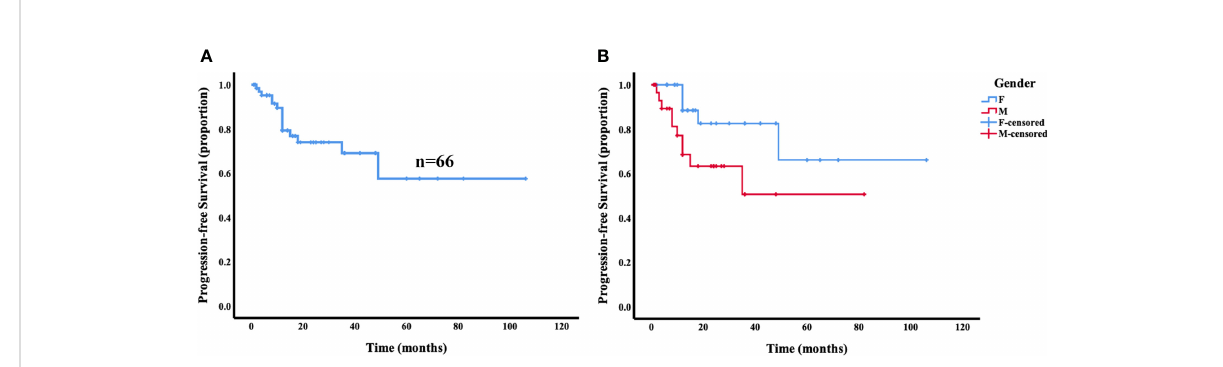
FIGURE 4 Progression-free survival (PFS) analysis for primary intraosseous RDD. The 5-year PFS of the patients with primary intraosseous RDD was 57.5% (A) . Female patients showed a trend toward superior progression-free survival compared with male patients ( p = 0.031) (B)